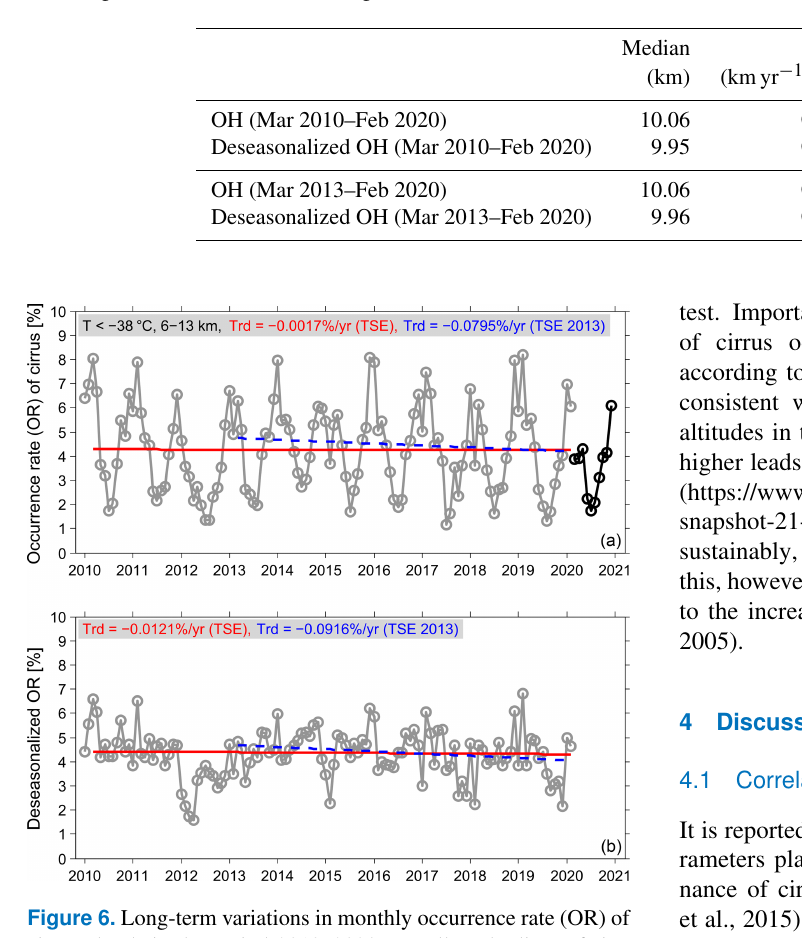
Table 4. Long-term trends of monthly occurrence height (OH) of cirrus clouds at the typical cirrus altitude range from 6 to 13km derived from both day- and night-time data during the period from March 2010 to February 2020 with the Theil–Sen estimator (TSE) method including the Mann–Kendall (MK) significance test.